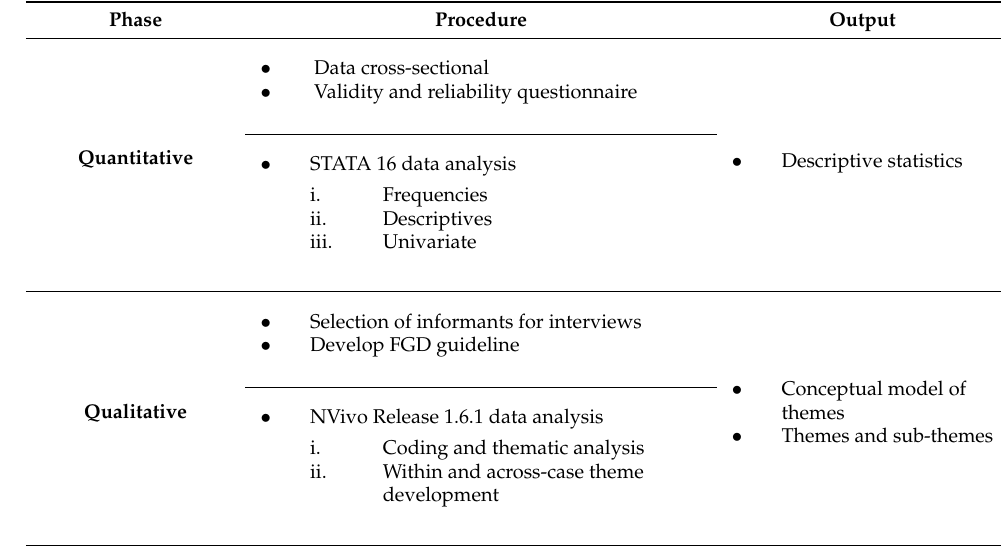
Table 1. The sequential explanatory mixed methods